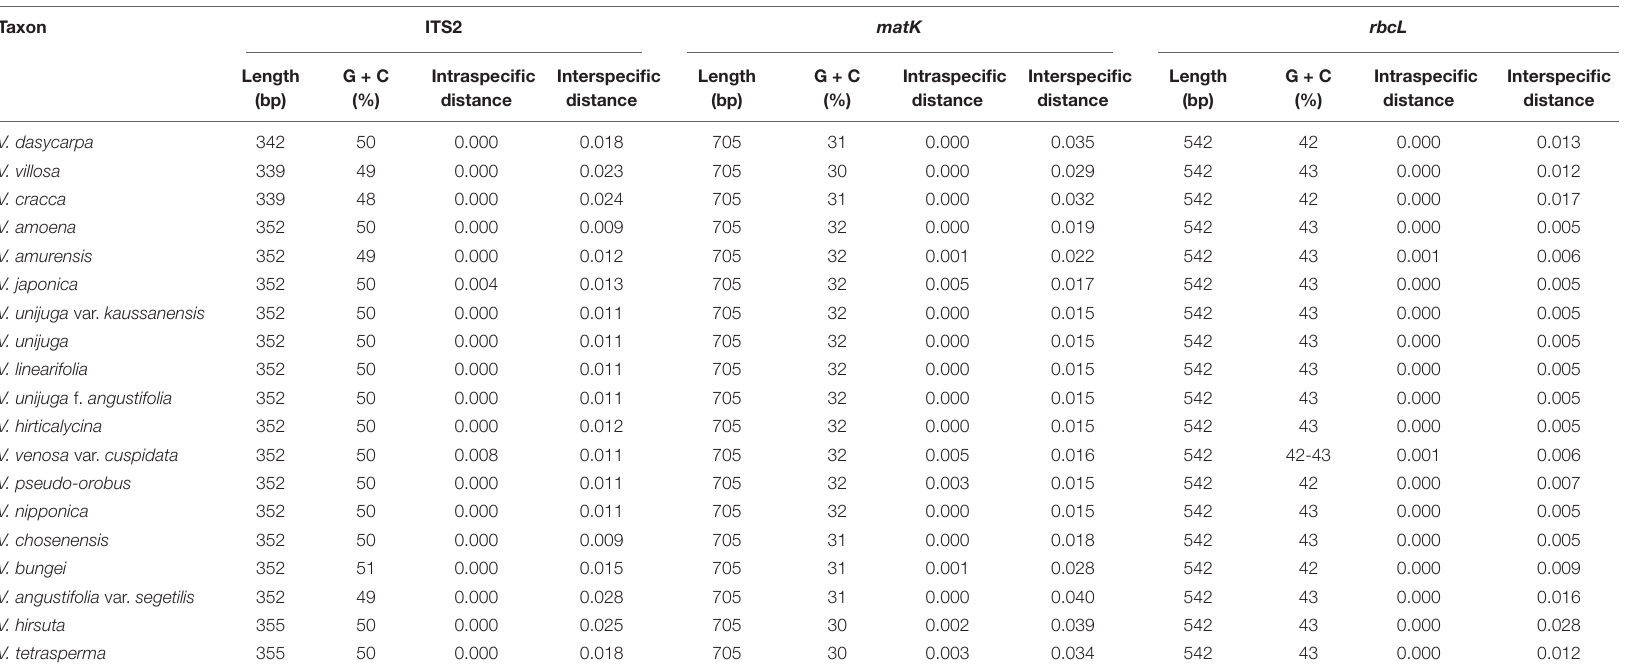
TABLE 3 | Characteristics and variation of the ITS2, matK , and rbcL region.